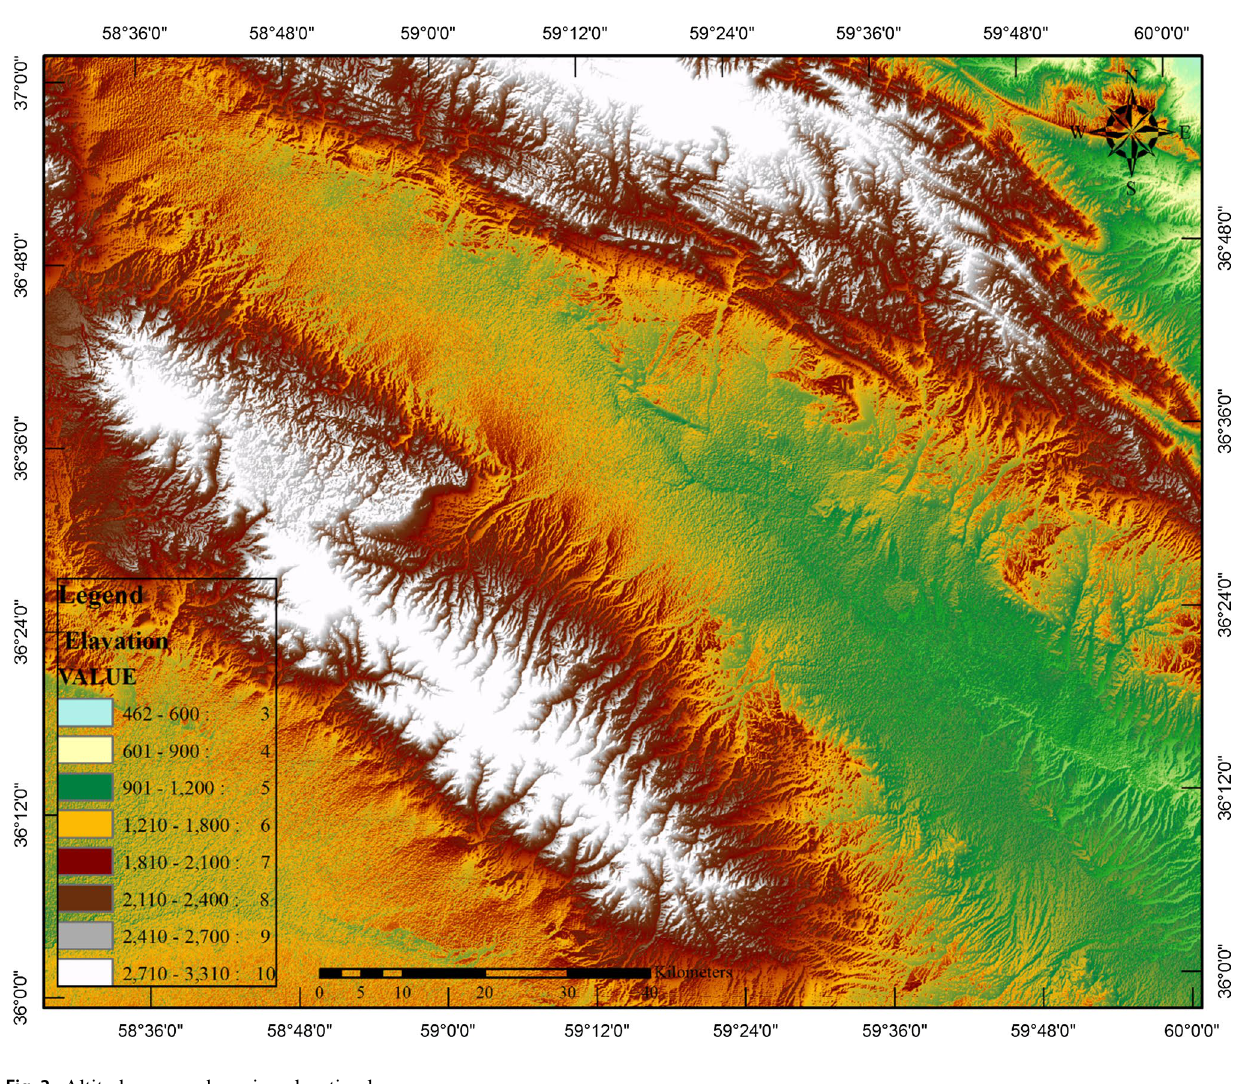
Fig. 3 Altitude map and scoring elevation layers